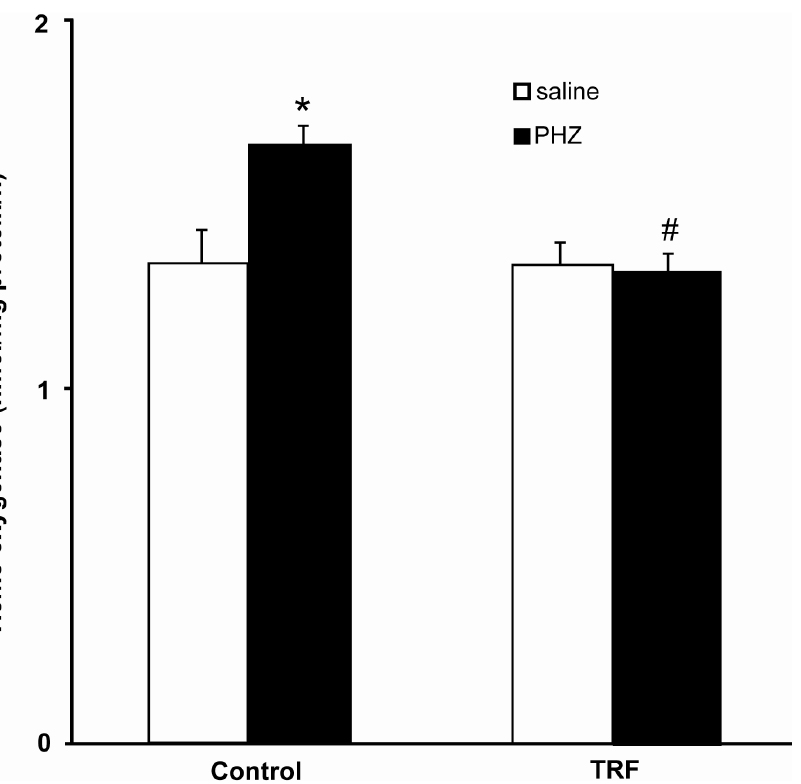
Figure 3. Hepatic heme oxygenase activity. Bars represent mean 6 standard error (n=6). *Different from the saline-treated group (p , 0.05), # different from the control + PHZ (0.05). [TRF: tocotrienol-rich fraction; PHZ: phenylhydrazine].